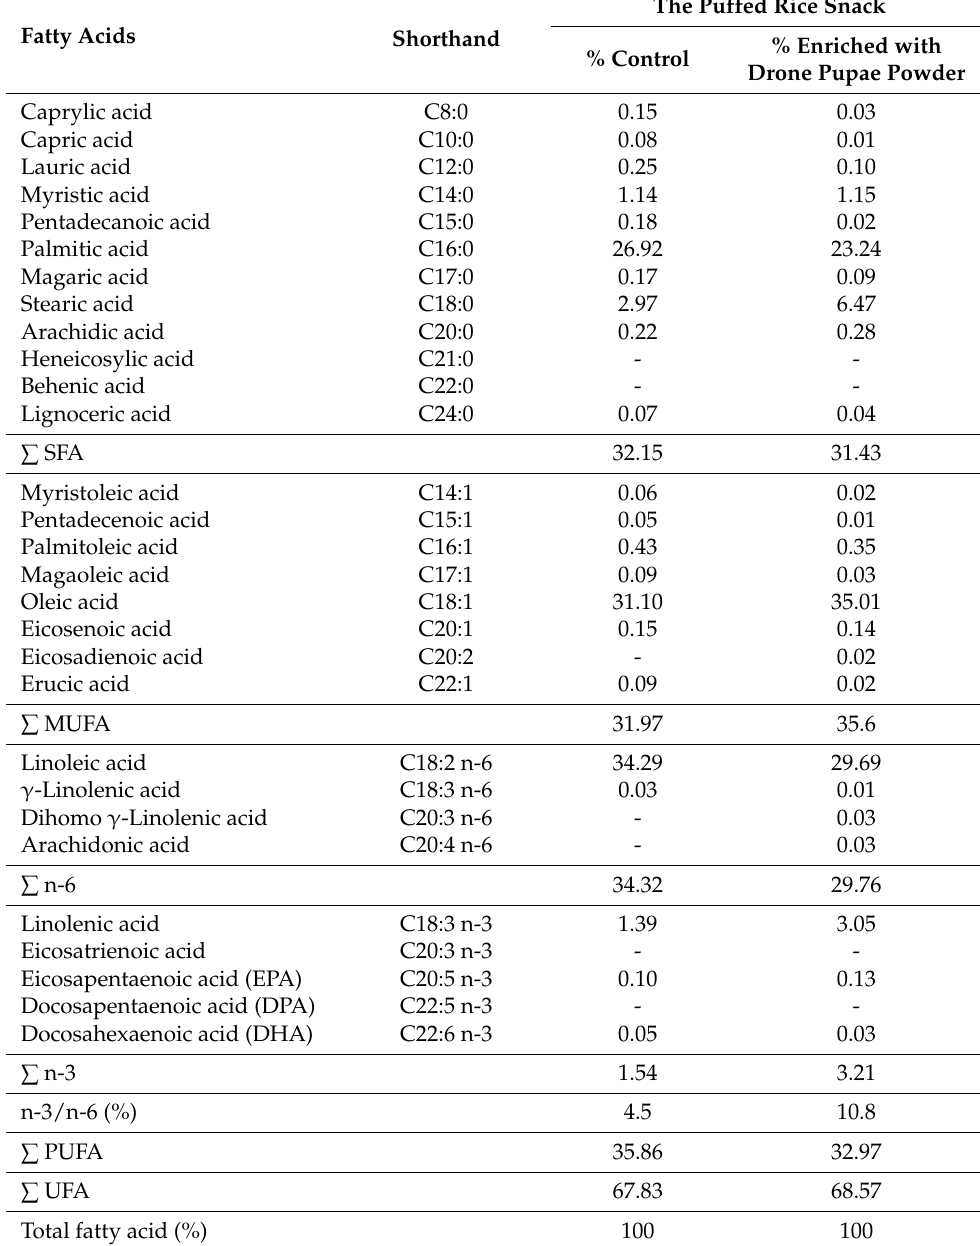
Table 15. Fatty-acid compositions of the control and drone-pupae-powder enriched puffed-rice snack (% of total fatty